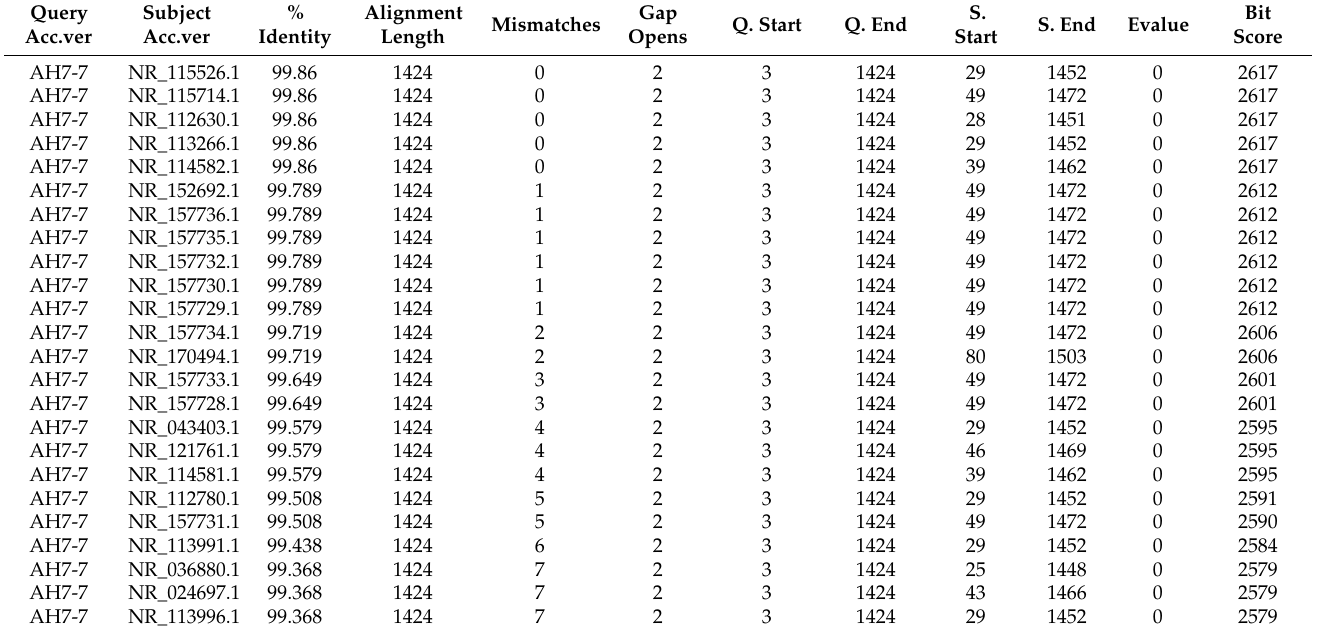
Table A1. Blast results of the 16S rRNA gene.